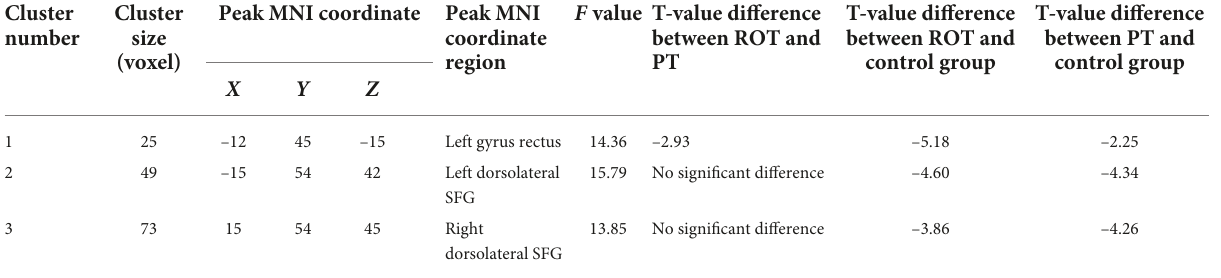
Table 2A Decreased ALFF activities in both ROT and PT groups compared to the control